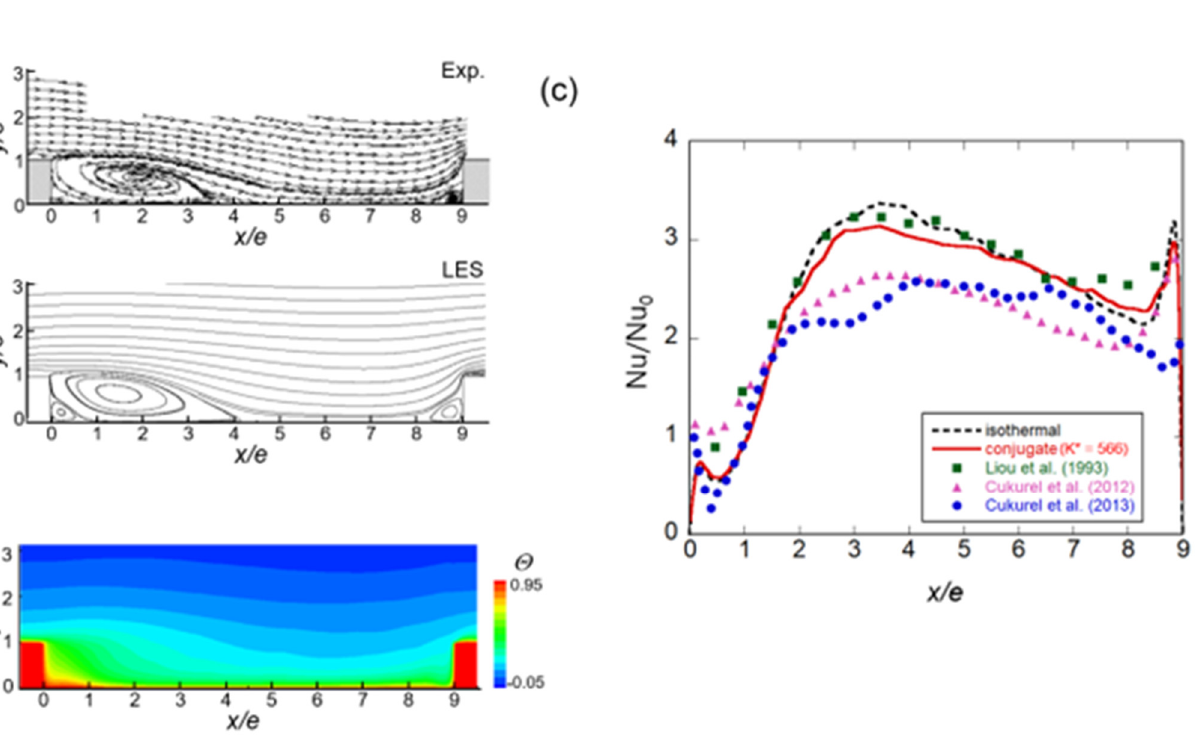
Figure 2. Time-averaged flow and thermal fields for the isothermal wall [21,26]: ( a ) time-averaged streamlines compared to the PIV measurement data of Casarsa et al. [41]; ( b ) time-averaged thermal field; and ( c ) heat transfer coefficient for the channel wall between the ribs.